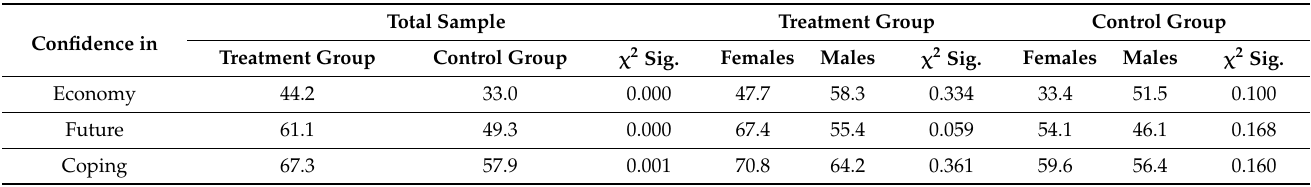
Table 2. Confidence in economic situations, the future, and coping in difficult life situations among women and men in the treatment and control groups. Share of those respondents with high or very high confidence